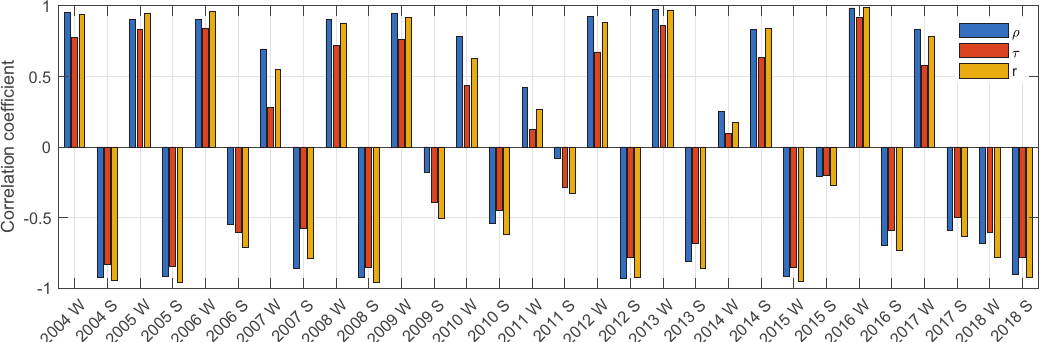
Figure 20. The Pearson ( ρ ), Kendall ( τ ) tau and Spearman rho (r) correlation coefficient between time series of detrended groundwater level and the cumulative sum of precipitation. W: winter season, S: summer season.